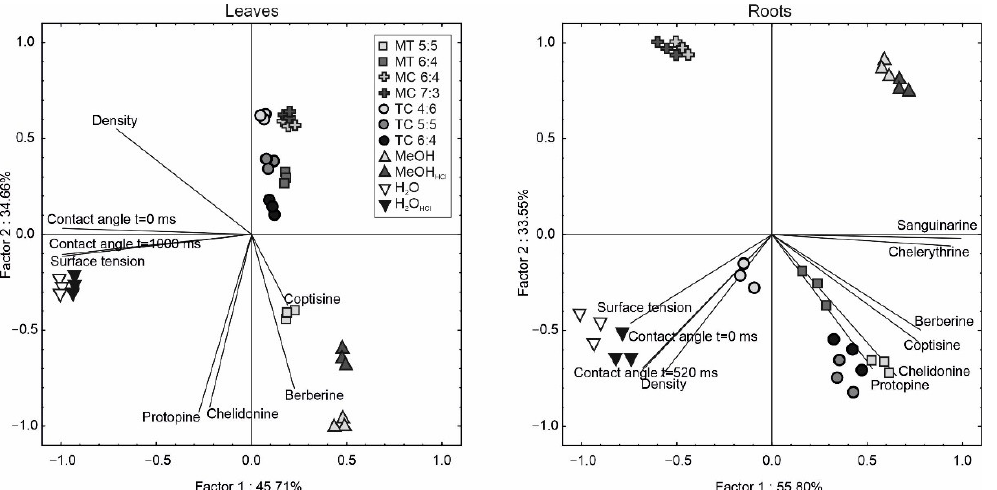
Figure 3. Scaled scatter plot of the principal component analysis of isoquinoline alkaloids and phys- ical properties of extractants (MT—Menthol-thymol mixtures; MC—Menthol-camphor mixtures; TC—Thymol-camphor mixtures. The mass:mass ratio of the components in the mixtures is shown next to the symbols. MeOH HCl and H 2 O HCl -MeOH and water acidified with hydrochloric acid to a concentration of 0.05 M. The length of the lines shows a correlation between original data and factor axes.